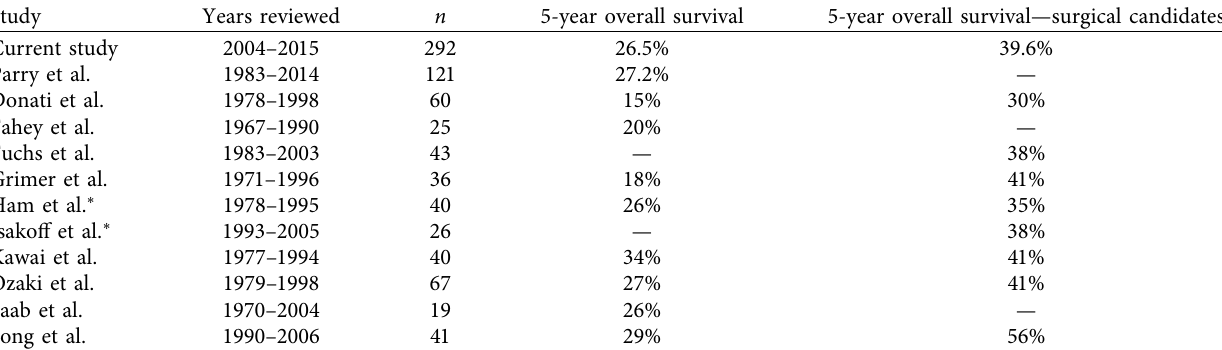
Table 4: Previously published manuscripts describing 5-year overall survival of osteosarcoma of the pelvis.